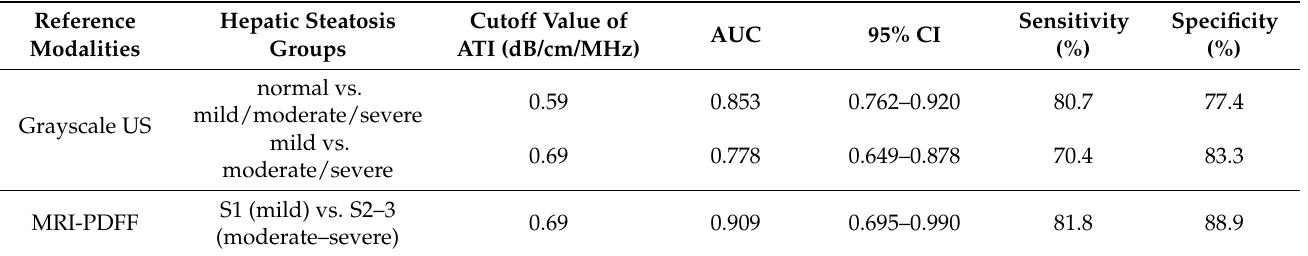
Table 4. Diagnostic performance of median ATI values for staging hepatic steatosis according to the grayscale US and